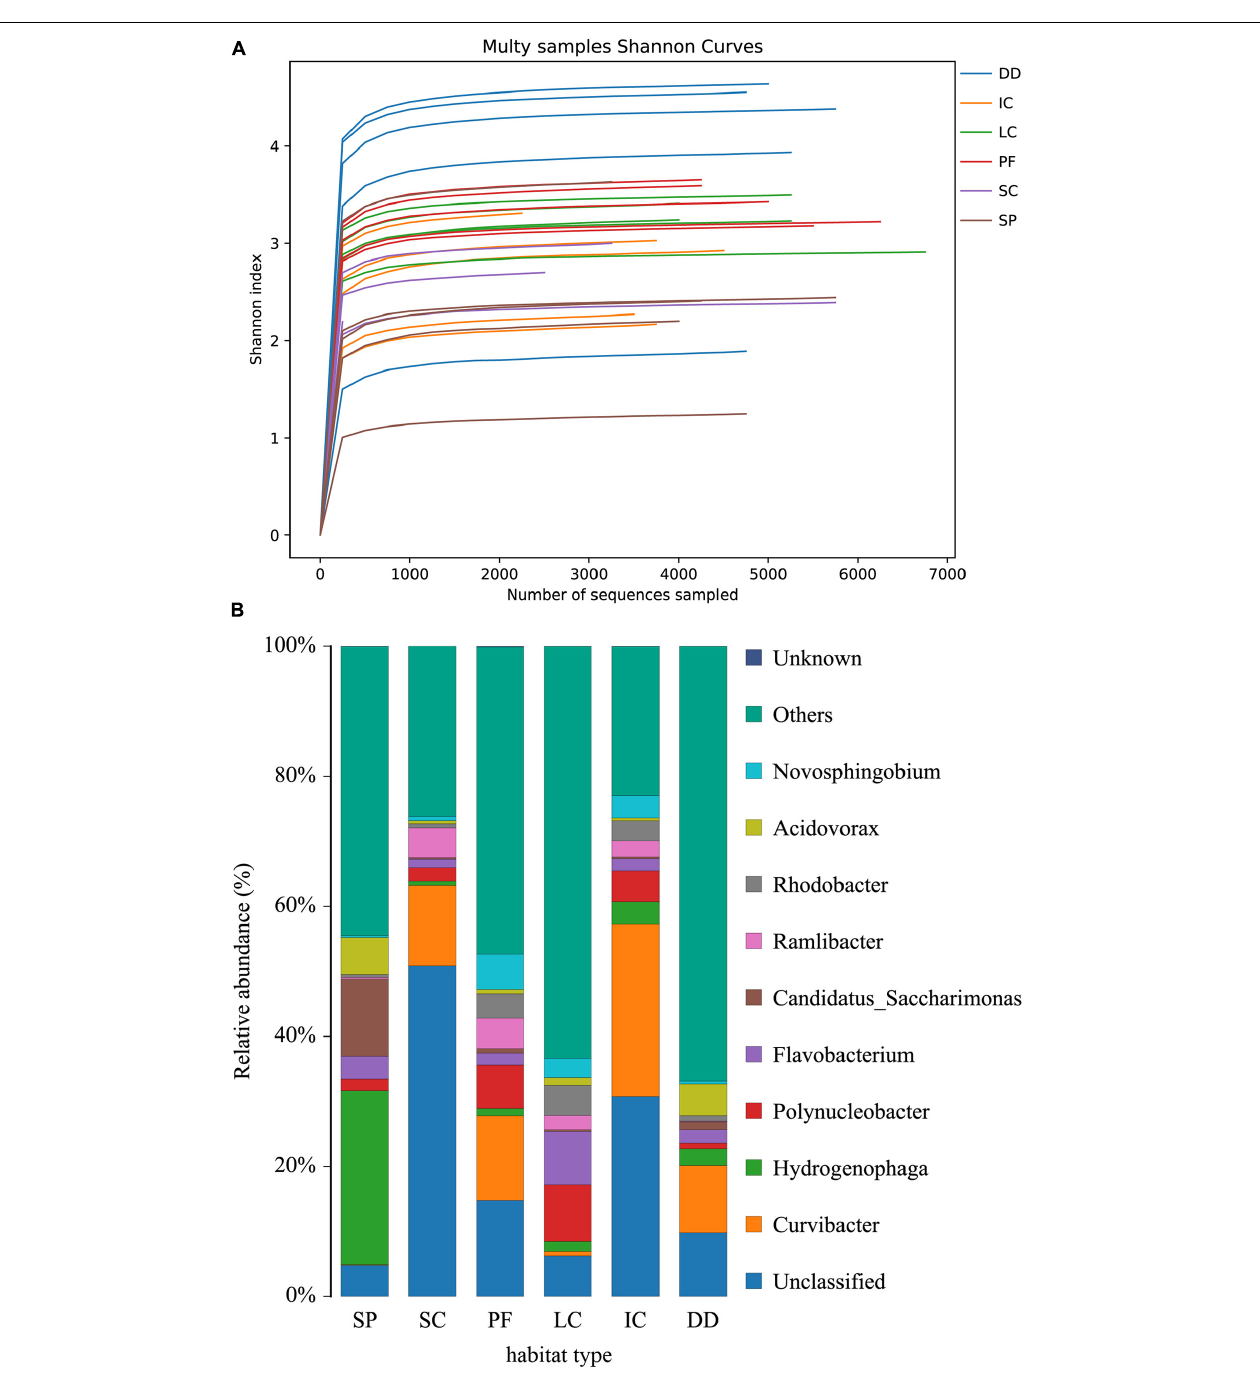
number of samples we tested from water bodies or the large variation in the diversity index of different habitat types.